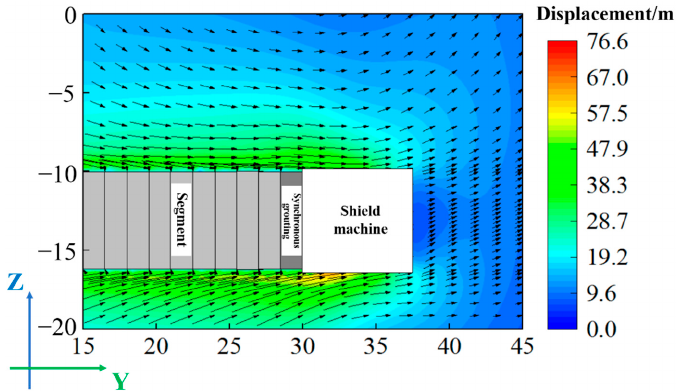
Figure 9. Displacement vector diagram in the longitudinal section.